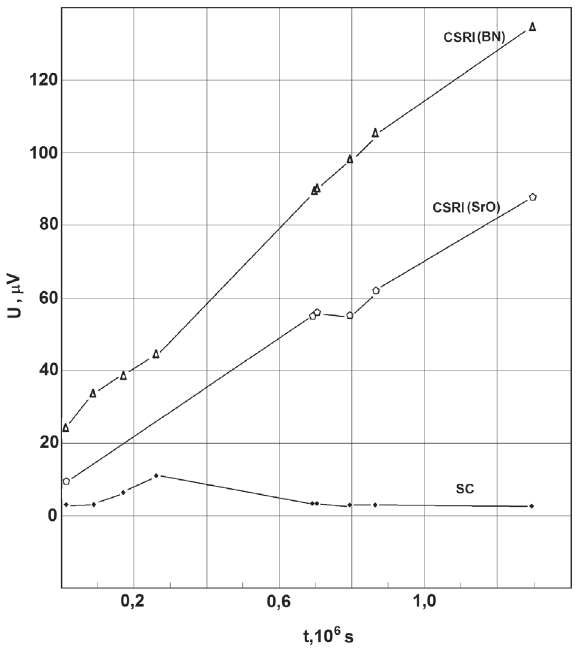
Figure 2. Difference of potentials as a function of time for the current source (CSRI) and supercapacitor (SC) specimens irra- diated with neutrons with a dose of 2.9·10 13 n/cm 2 .